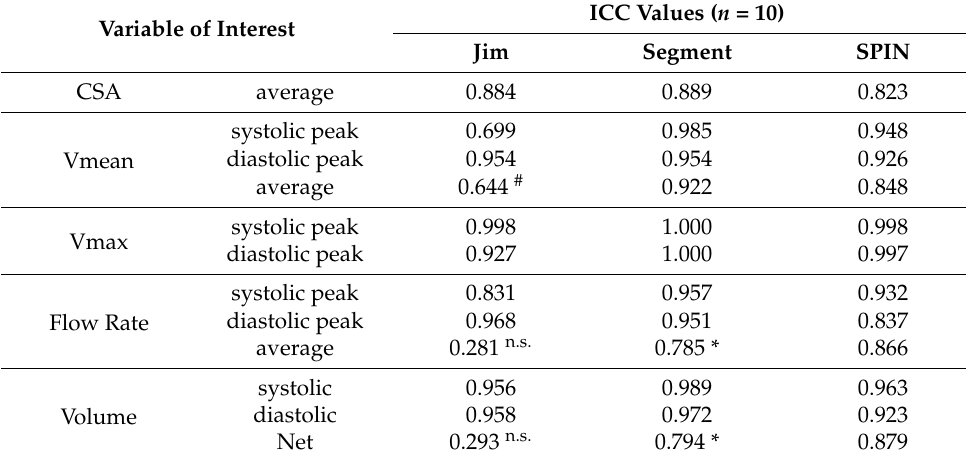
Table 2. Intra-class correlation coefficient (ICC) values for each variable of interest and each software package. All the ICCs are significant, with the exception of the average flow rate and net volume computed with Jim. The p -values different from p < 0.001 are